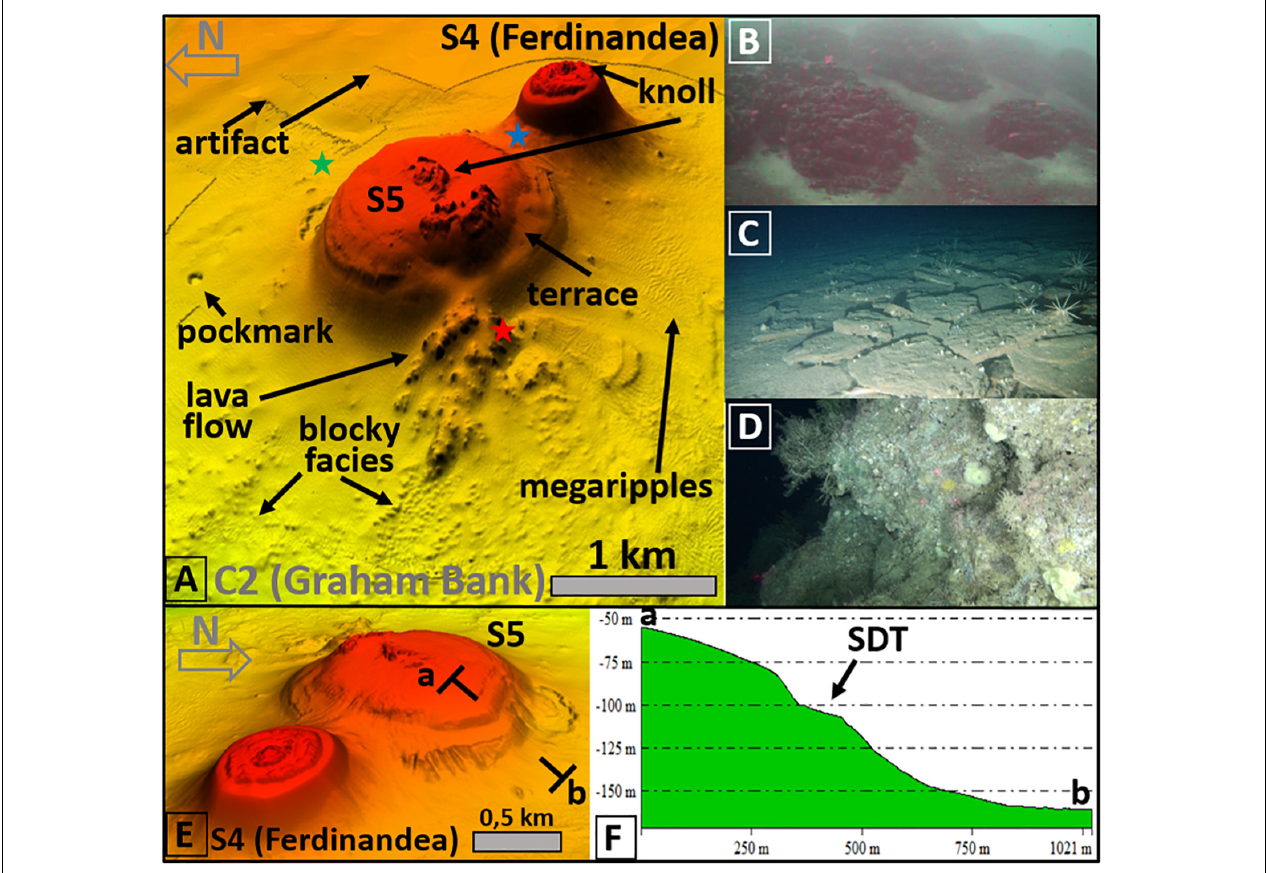
FIGURE 5 | (A) 3D view (vertical exaggeration = 4x) of the Graham Bank (C2 cluster) viewed from the west; the blue star indicates the location a ROV photo (B) displaying a group of mounds on the saddle between S4 (the Ferdinandea shoal) and S5 seamounts; the green star indicates the location of the ROV photo (C) displaying pieces of semi-consolidated pyroclastic layers on the seabottom; the red star indicates the location of the ROV photo (D) displaying the lateral front of a lava flow on the low western side of S5. (E) 3D view (vertical exaggeration = 2x) of the Graham Bank from the east showing a 200–300 m wide terrace at about 100 m bsl along the slope of S5, which bathymetric profile (ab) is displayed in (F) .